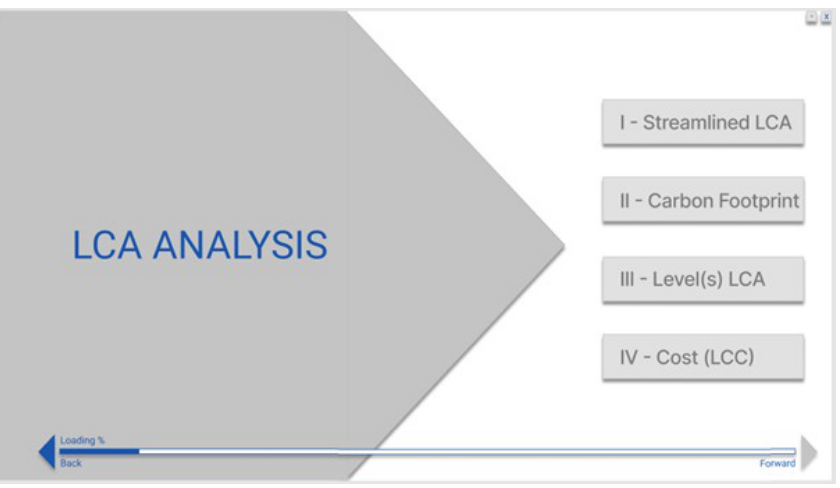
Figure 4. Plugin functionalities options.